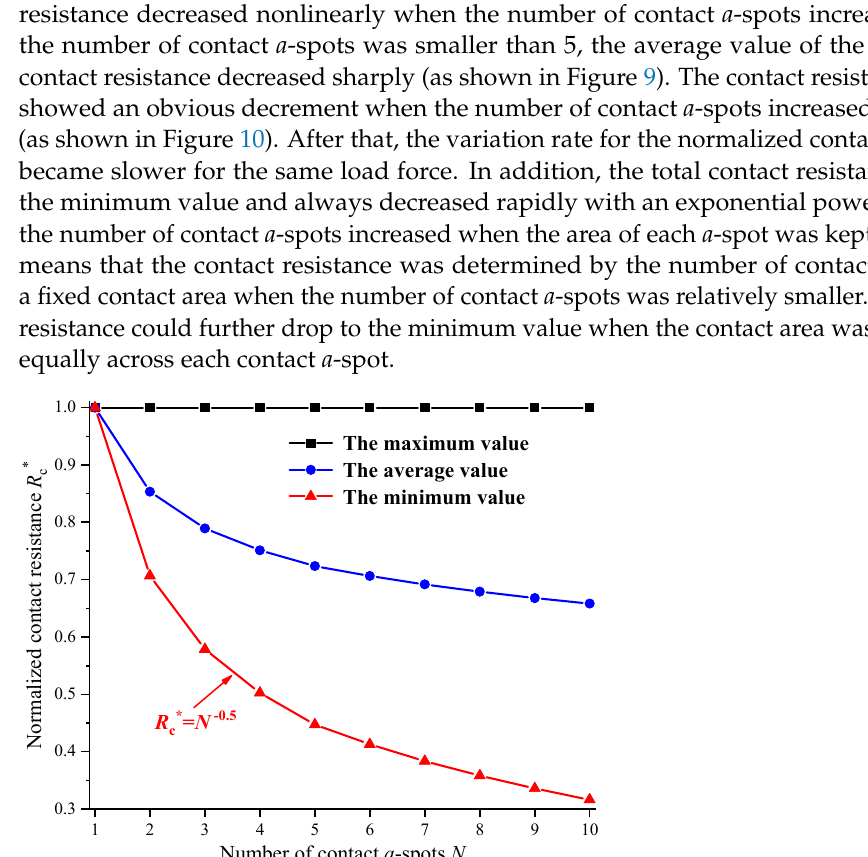
Figure 10. The variations in the normalized contact resistance as a function of the normalized load force with a varying number of contact a -spots. When the area of one contact a -spot approaches S for N contact a -spots, the contact resistance is mainly determined by this contact a -spot and reaches the maximum value. Moreover, it was found that the average and minimum values of the normalized contact resistance decreased nonlinearly when the number of contact a -spots increased. When the number of contact a -spots was smaller than 5, the average value of the normalized contact resistance decreased sharply (as shown in Figure 9). The contact resistance always showed an obvious decrement when the number of contact a -spots increased one by one (as shown in Figure 10). After that, the variation rate for the normalized contact resistance became slower for the same load force. In addition, the total contact resistance reached the minimum value and always decreased rapidly with an exponential power of − 0.5 as the number of contact a -spots increased when the area of each a -spot was kept equal. This means that the contact resistance was determined by the number of contact a -spots for a fixed contact area when the number of contact a -spots was relatively smaller. The contact resistance could further drop to the minimum value when the contact area was distributed equally across each contact a -spot.